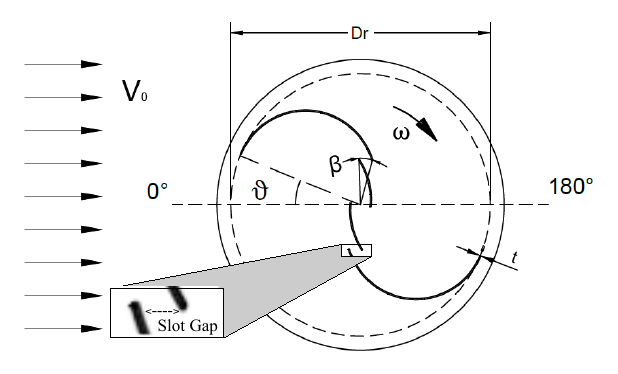
Figure 15. Savonius geometry with slot angle “ β ” definition.